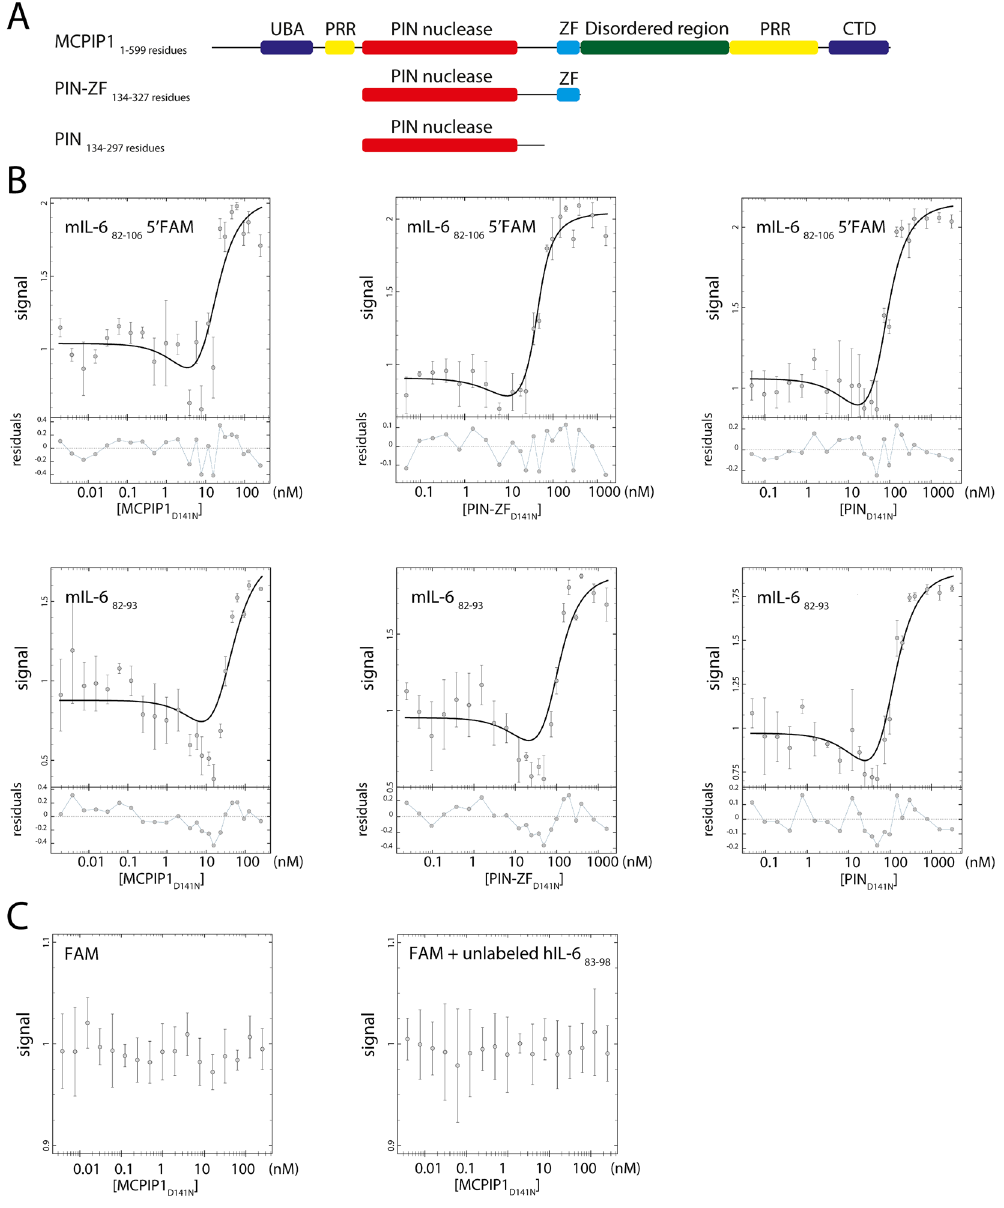
Figure 4. ( A ) Domain characterization of MCPIP1: UBA 43–89 (Ubiquitin-associated domain); PRR 100–126 and 458–536 (Proline-rich region); PIN 133–270 (PilT N-terminus nuclease domain); ZF 305–325 (zinc-finger motif); disordered region 326–457 ; CTD 545–598 (C-terminal conserved domain). Depicted fragments of MCPIP1, PIN-ZF and PIN that were used in presented studies. ( B ) Affinity of the MCPIP1 interaction with oligonucleotides forming RNA stem-loop structures: mIL-6 82–106 5 ′ FAM and single-stranded RNA oligonucleotides represented by mIL-6 82–93 . The analyzed proteins were the catalytic mutated forms: MCPIP1 D141N and its PIN-ZF D141N and PIN D141N fragments. The ribonuclease PIN D141N domain was studied without or with the zinc finger motif at the C-terminal region. Graphs illustrate the interaction of selected proteins (MCPIP1 D141N , PIN-ZF D141N , and PIN D141N ) with oligonucleotides. Functions were fitted to the fluorescence intensity data points using the sequential binding model N + P + P  NP + P  NPP (P – protein N – oligonucleotide). The depicted errors bars are standard deviations, n = 3. ( C ) Controls of the affinity determination assay. MCPIP1 D141N in a presence of the free FAM label and unlabeled hIL-6 81–98 RNA